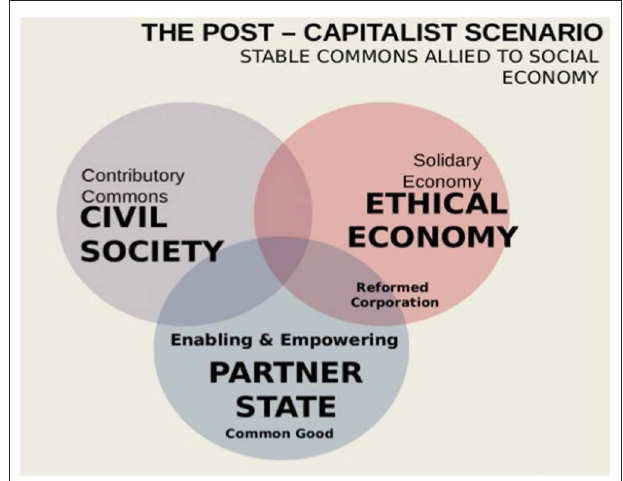
FIGURE 2 | The post-capitalist scenario of a stable commons allied to a social economy (used with permission. Graphic by Michel Bauwens. Published in the Flok Society, http://floksociety.org, transition plan, https://book.floksociety.org/ ec/ draft pdf, 2014).